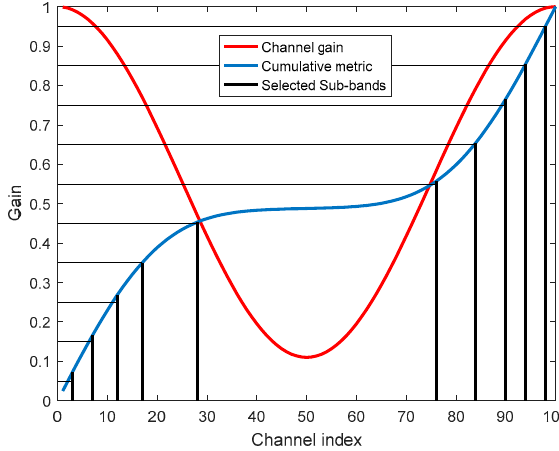
Figure 7. Channel selection for Matched Frequency Hopping (MFH) technique. The red line represents the channel gain and the blue line represents the cumulative sum of the power metric. The selected channels are represented as vertical black lines. The best channels are selected from the intersections between the cumulative metric and the equally spaced horizontal lines.